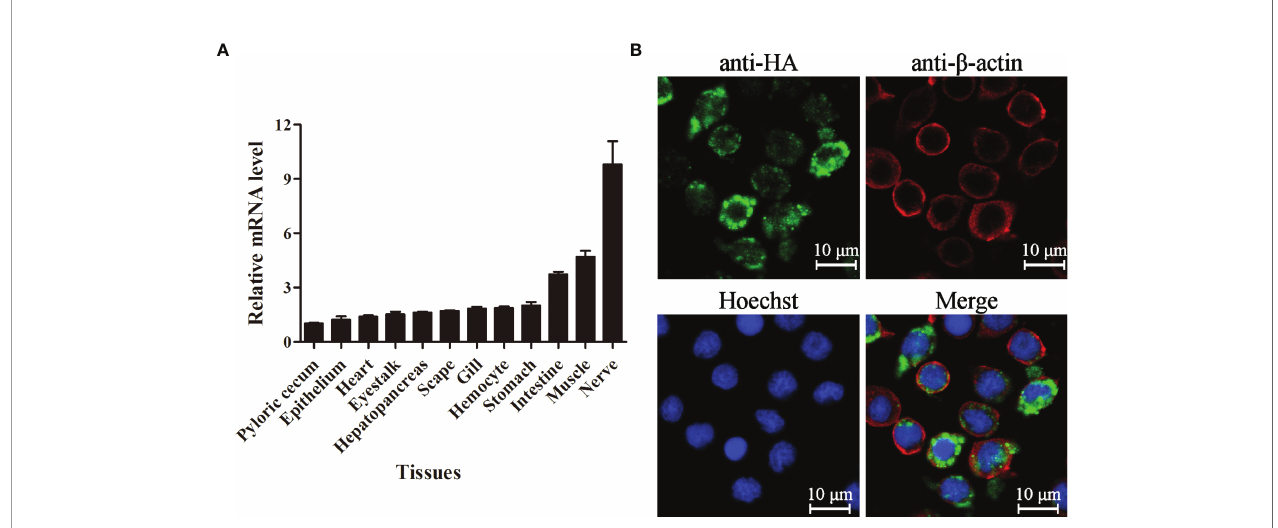
FIGURE 3 | Tissue distribution and subcellular localization of LvPTPN6. (A) Expression of LvPTPN6 in L. vannamei tissues detected by qRT-PCR with EF-1 a as internal control. The expression level of LvPTPN6 in pyloric cecum was set as the baseline (1.0). Each bar represents the mean ± SD ( n = 4). (B) Subcellular localization of HA-tagged LvPTPN6 was detected by confocal laser scanning microscopy analysis in S2 cells. LvPTPN6 was stained with Alexa Fluor 488 (green), the cytomembranes were visualized by b -actin stain with Alexa Flour 594 (red), and the nuclei were stained with Hoechst 33342